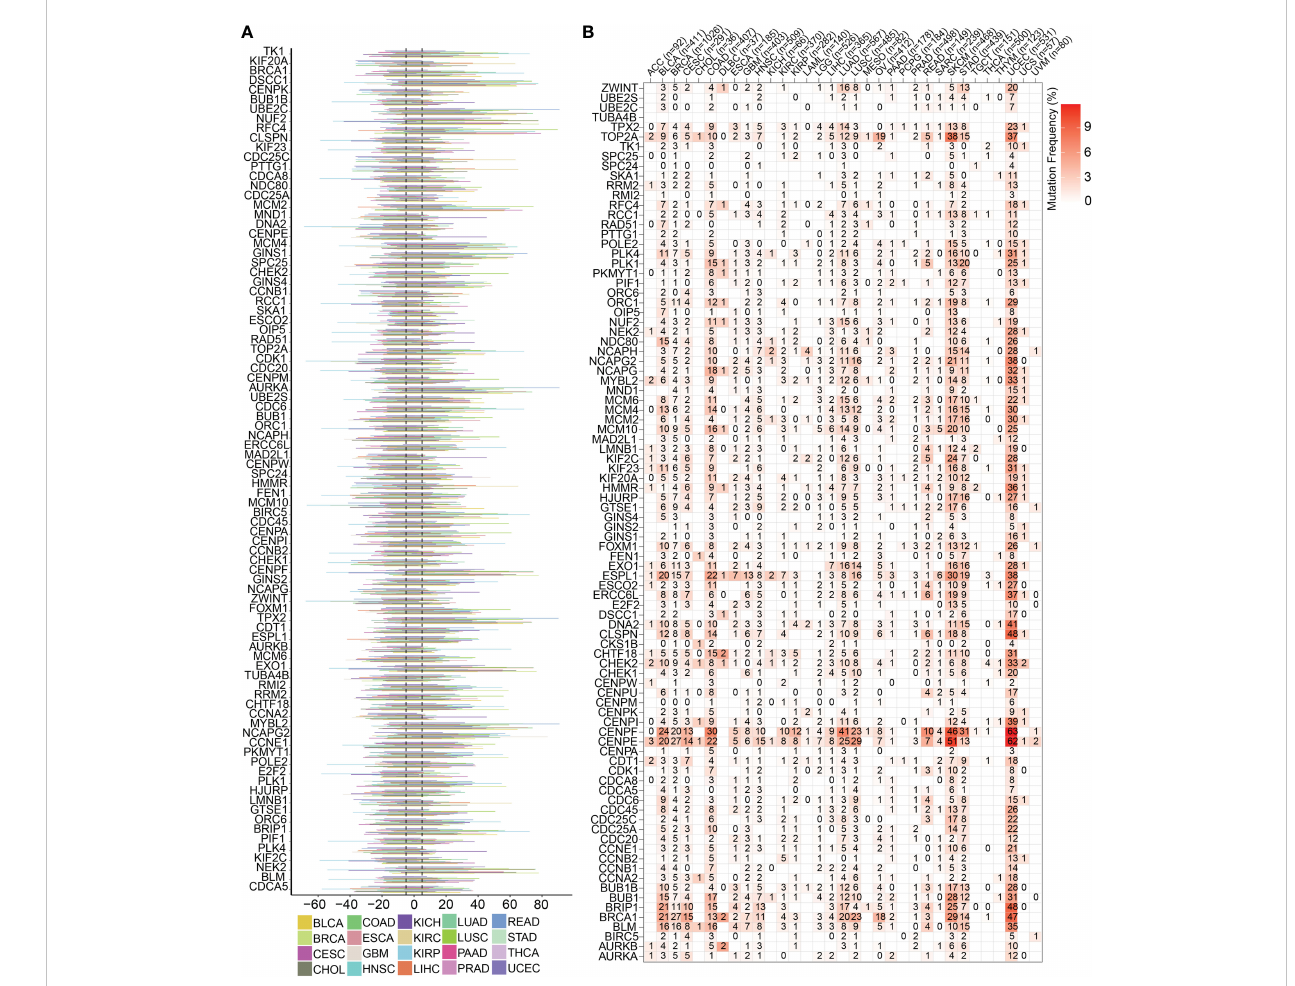
FIGURE 2 Genomics traits of cell cycle-related genes in pan cancer. (A) CNV outcomes of the 93 cell cycle-related genes in different types of cancers. The length line represents the wave frequency of the cell cycle-related genes in human malignant tumors. (B) Heatmap representing the SNV mutations for the 93 cell cycle-related